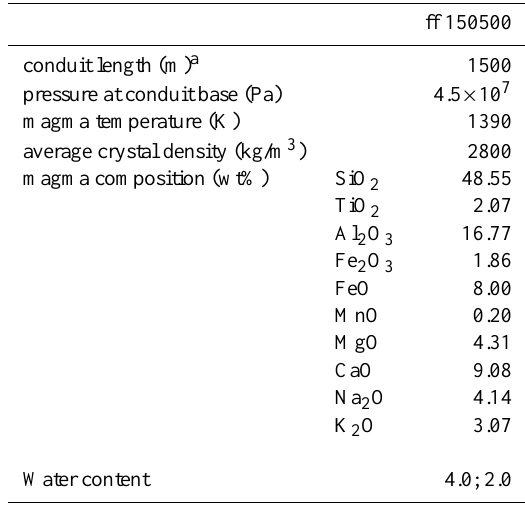
Table 3. Input data for the numerical simulations. The composition of a sample from 15 May 2000 (ff150500), has been selected as a typical